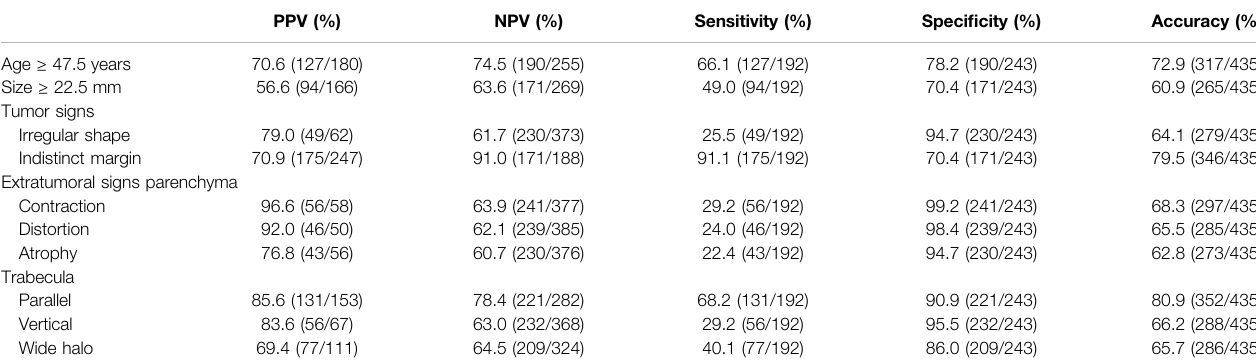
TABLE 4 | Statistical diagnostic indicators of independent malignant risk factors.